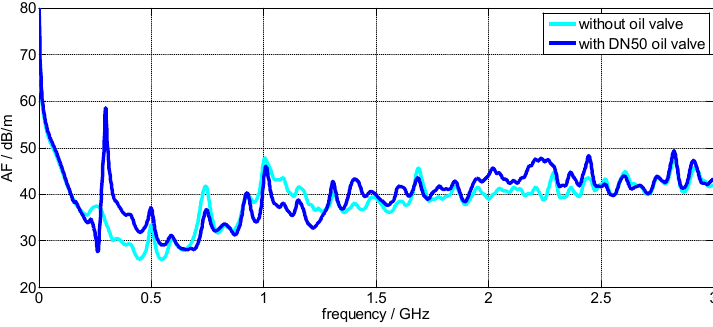
Figure 3. Transmission measurement ( S 21 ) for antenna factor (AF) determination [13].